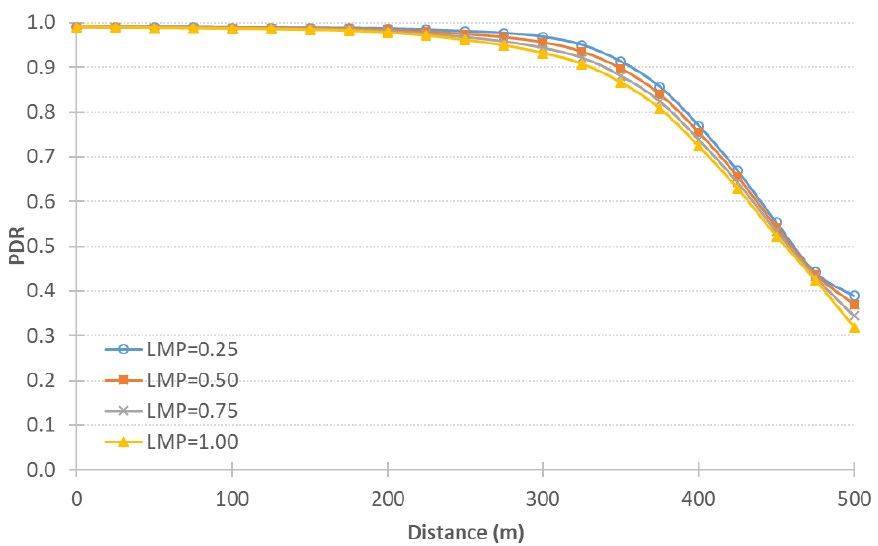
Figure 8. QNET results using different